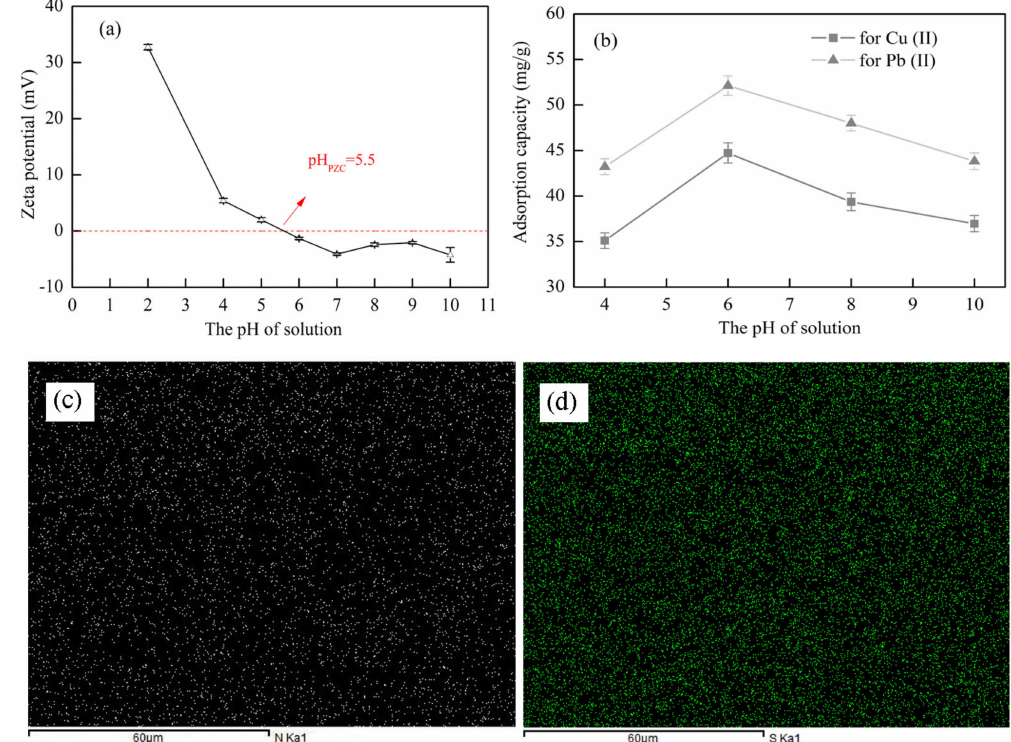
Figure 7. ( a ) Zeta potential curves as a function of pH; ( b ) The metal ion adsorption capacity of x CNC/CS/PVA-SH composite nanofibrous films at different pH; ( c ) N mapping of ( d ) S mapping images. (A colour version of this image can be viewed